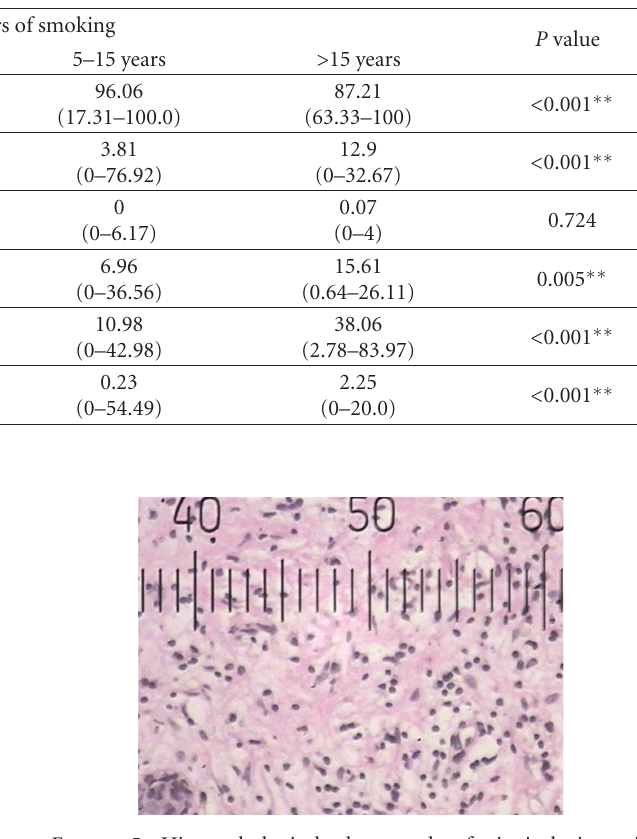
Figure 3: Histopathological photograph of gingival tissue in smoker showing larger blood vessels.